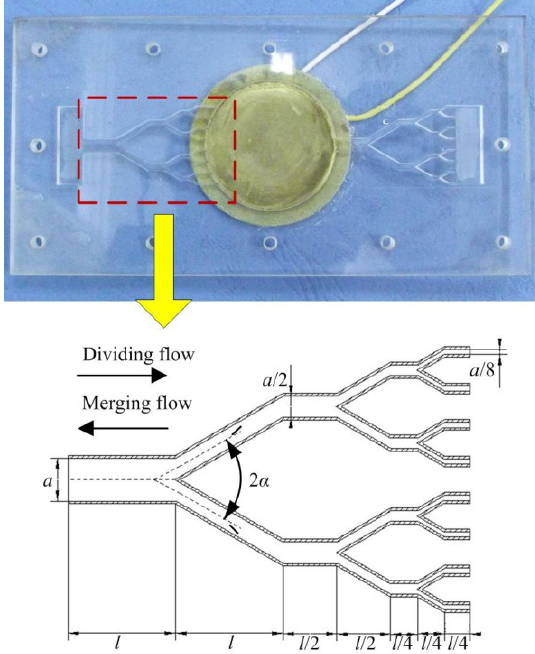
Figure 1. Valveless piezoelectric pump with multistage Y-shape treelike bifurcate tubes. Table 1. Parameters of the valveless piezoelectric pump with multistage Y-shape treelike bifurcate tubes. Parameter Symbol Parameter